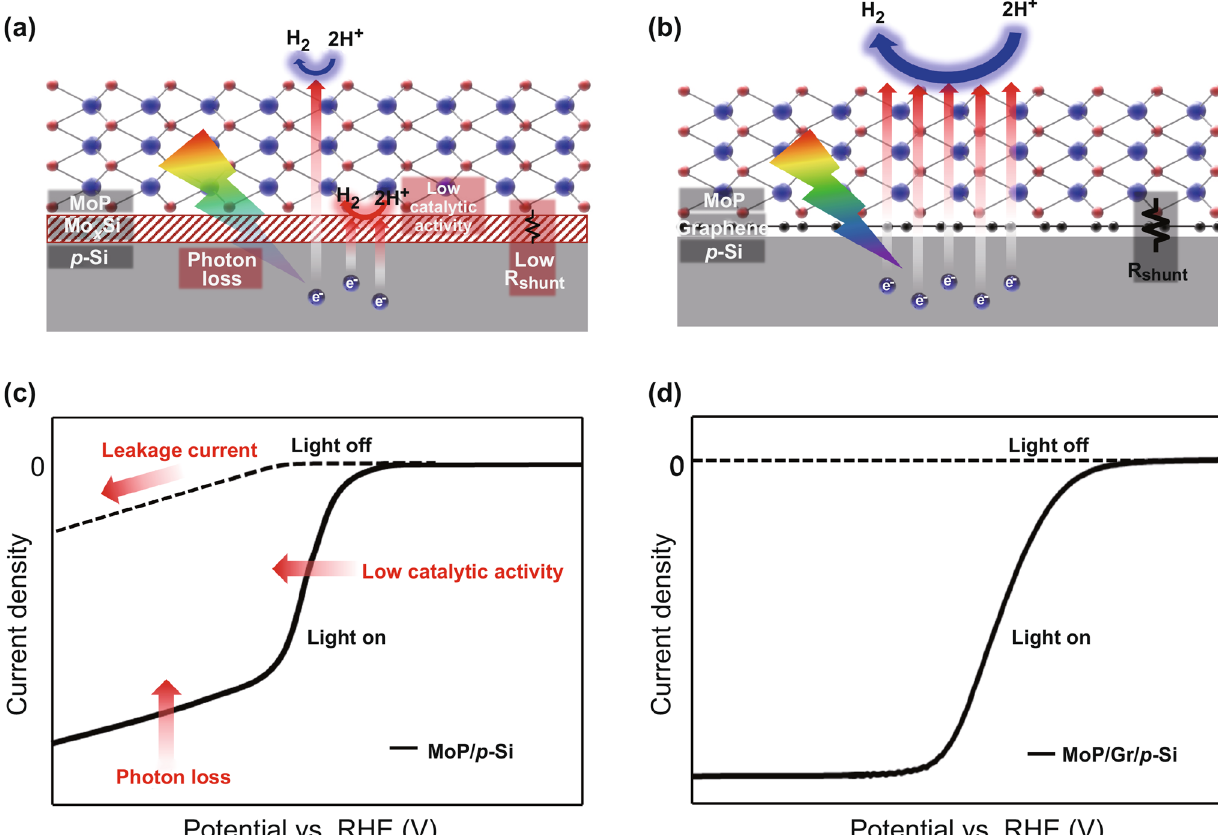
Fig. 1 Schematic illustrations of MoP synthesized on a bare p‑Si with Mo x Si and b graphene passivated p‑Si. Linear sweep voltammograms of c MoP/p‑Si photocathode with photon loss and low catalytic activity and d MoP/graphene/p‑Si photocathode showing enhanced PEC perfor‑